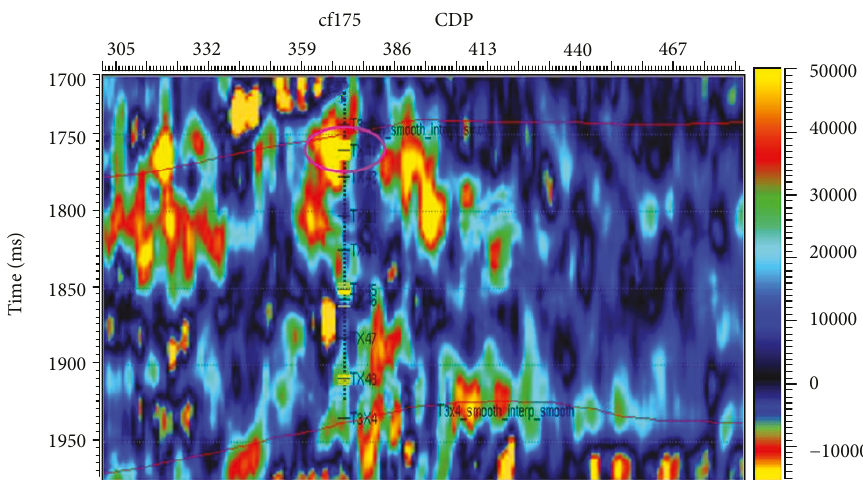
Figure 8: The inversion pro fi le through well cf175. The region marked by the purple ellipse is a good conventional gas reservoir. It has big value of P-wave dispersion gradient. Our inversion results match the well tests in this domain.